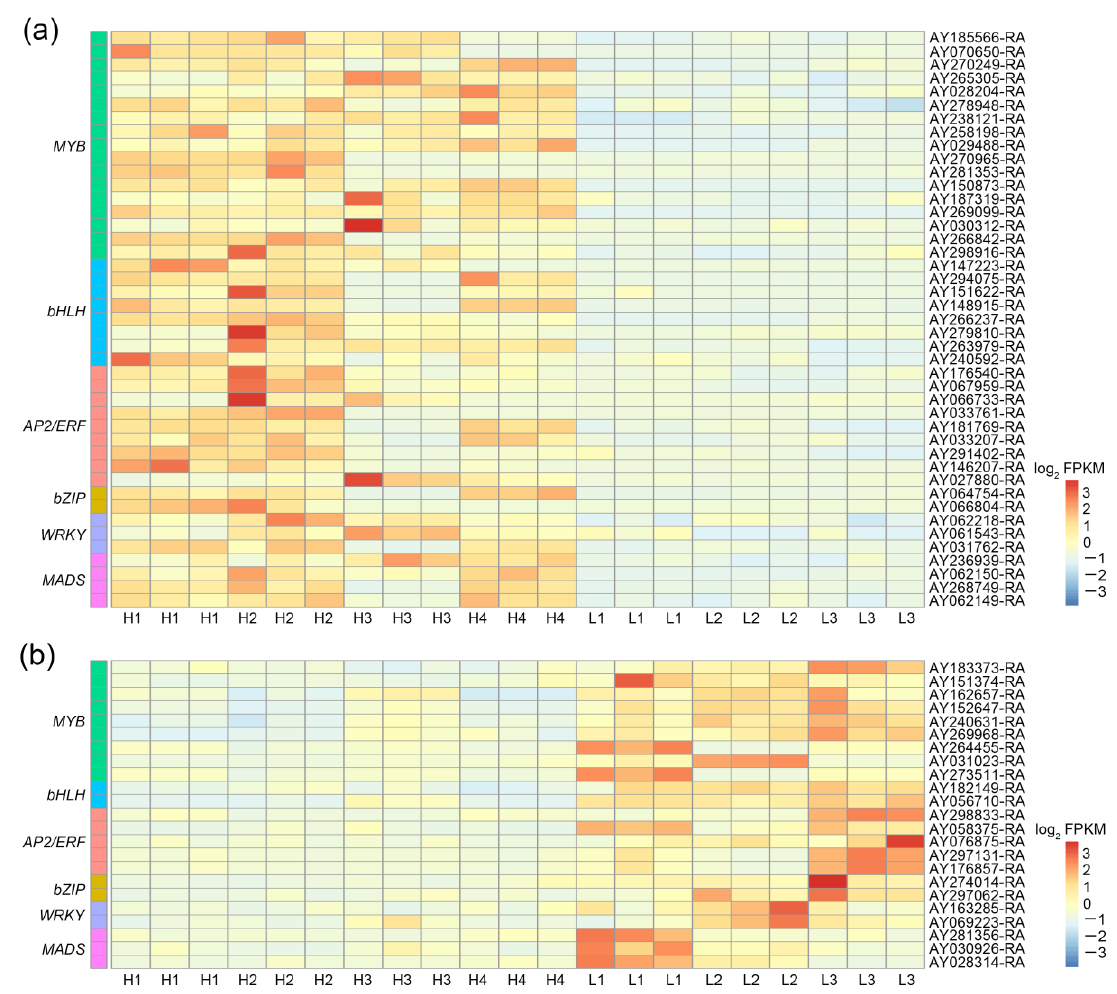
Figure 5. The identification of differentially expressed transcription factor-encoding genes between two groups of materials with different thujone content. ( a ) Upregulated transcription factor-encoding genes including MYB , bHLH , AP2/ERF , bZIP , WRKY , and MADS in A. argyi varieties with high thujone content compared to A. argyi varieties with low thujone content. ( b ) Downregulated transcription factor-encoding genes including MYB , bHLH , AP2/ERF , bZIP , WRKY , and MADS in A. argyi varieties with high thujone content compared to A. argyi varieties with low thujone content. H1, H2, H3, and H4 indicate four varieties with high thujone content. L1, L2, and L3 indicate three varieties with low thujone content.